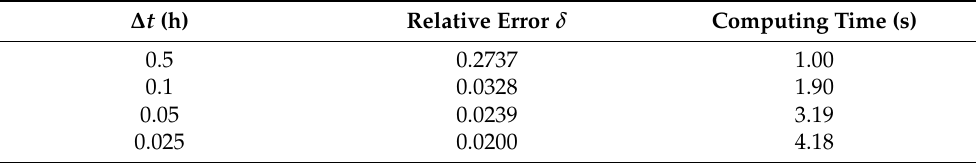
Table 7. Relative error and computing time of the HIM method when ∆ t is different. ∆ t (h)